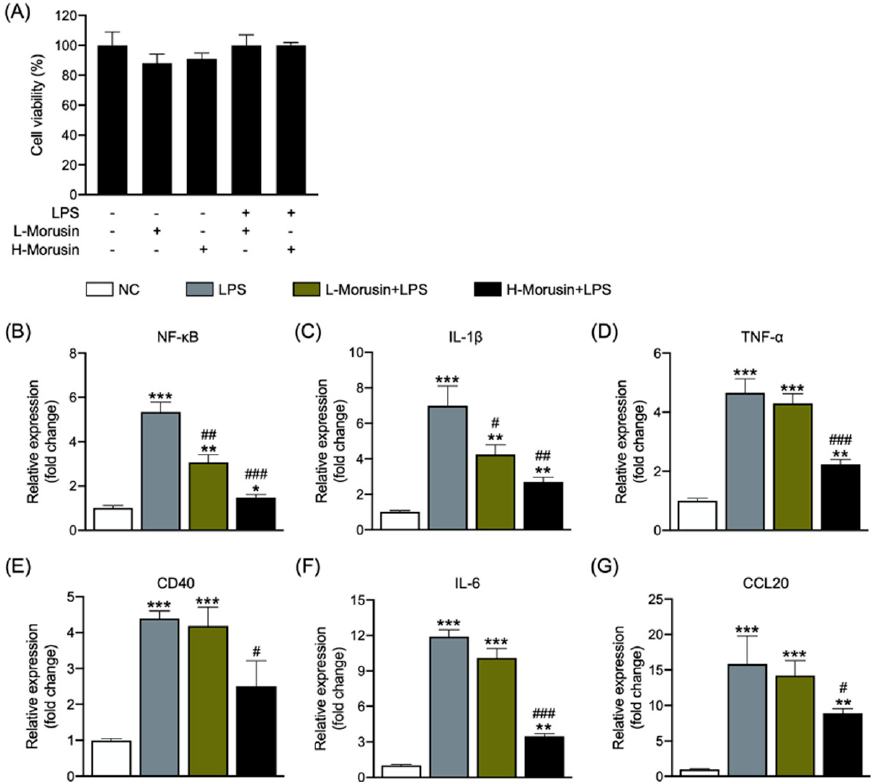
Figure 1. Effects of Morusin on cell viability ( A ) and gene expression of proinflammatory factors NF- κ B ( B ), IL-1 β ( C ), TNF- α ( D ), CD40 ( E ), IL-6 ( F ), and CCL20 ( G ) in ruminal epithelial cells (RECs) upon lipopolysaccharide stimulation. RECs were treated without (NC, n = 4) or with 0.1 µ g/mL lipopolysaccharide for 3 h after pretreating with 25 or 50 µ g/mL of Morusin for 12 h (L-Morusin+LPS, n = 4; H-Morusin+LPS, n = 4) or not (LPS, n = 4). Data represent mean ± SEM. * p < 0.05, ** p < 0.01, *** p < 0.001 vs. NC; # p < 0.05, ## p < 0.01, ### p < 0.001 vs. LPS. An average of 46.13 million clean reads per sample were obtained from transcriptome sequencing after raw data cleaning. Through calculating FPKM (fragments per kilobase of transcript per million fragments mapped) of all the genes that mapped to Ovis aries in each sample, a similar gene expression distribution was observed. After comparing the differentially expressed genes (DEGs) ( p adj < 0.05 and fold change > 2) among all the treatments, there were 1507 genes significantly upregulated, and 1232 genes were significantly downregulated in the LPS group compared with the expression levels in the NC group. Simultaneously, 1169 genes were significantly upregulated, and 1304 genes were significantly downregulated in the Morusin+LPS group compared with the LPS group. Specifically, 1107 overlapping genes were significantly upregulated with the LPS stimulation alone (LPS vs. NC up) and downregulated with the pretreatment of Morusin upon LPS stimulation (Morusin+LPS vs. LPS down), while 978 overlapping genes were significantly downregulated with the LPS stimulation alone (LPS vs. NC down) and upregulated with the pretreatment of Morusin upon LPS stimulation (Morusin+LPS vs. LPS up) (Figure 2A). Hierarchical cluster analysis of these overlapping DEGs further showed that the gene expression profile in the NC and Morusin+LPS groups were clearly separated from the LPS group (Figure